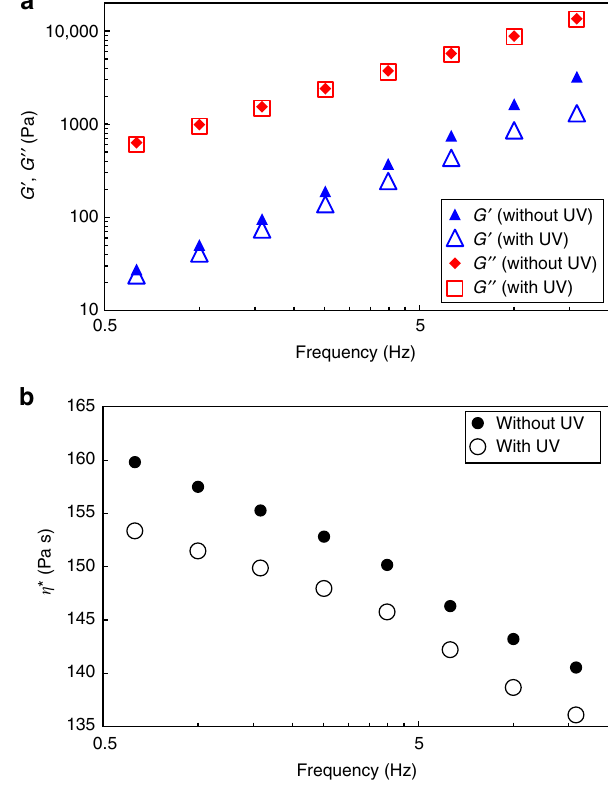
Fig. 6 Frequency dependence on rheological properties with and without UV irradiation. a Frequency-dependent plots of G ′ and G ″ for network- PDMS HABI ( G ′ without UV: blue triangle , G ′ with UV: blue open triangle , G ″ without UV: red diamond , G ″ with UV: red open square ). b Frequency- dependent plots of η * without ( black circle ) and with ( black open circle ) UV